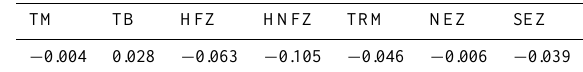
Table 7. The linear trends for GWLs with the highest Ec for R75p nad R95p indices in Crkvice and Herceg